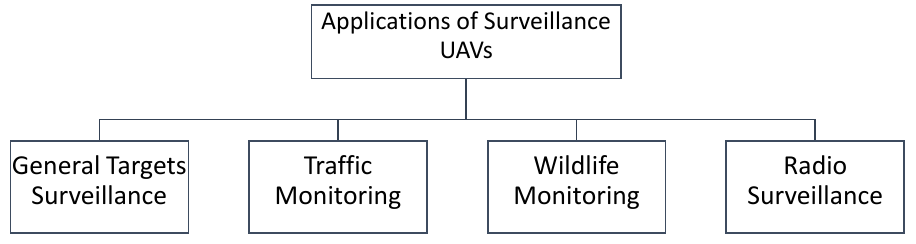
Figure 3. Surveillance UAV applications categorized by the target of interest.